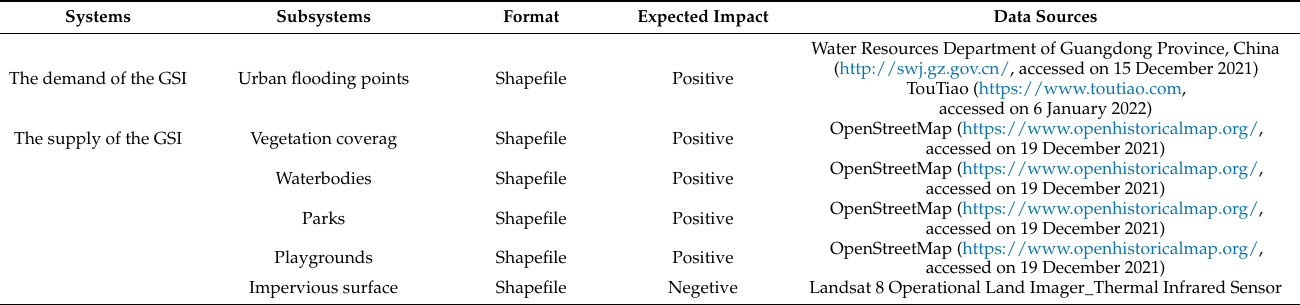
Table 1. The index system for coupling coordination evaluation in Green Stormwater Infrastructure (GSI).